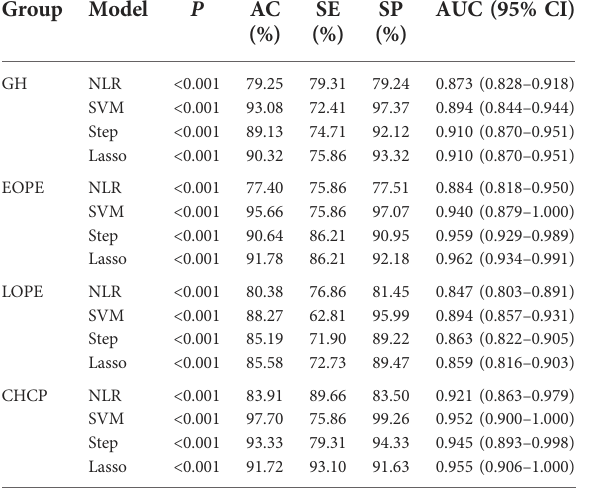
TABLE 12 Test results of the models. Group